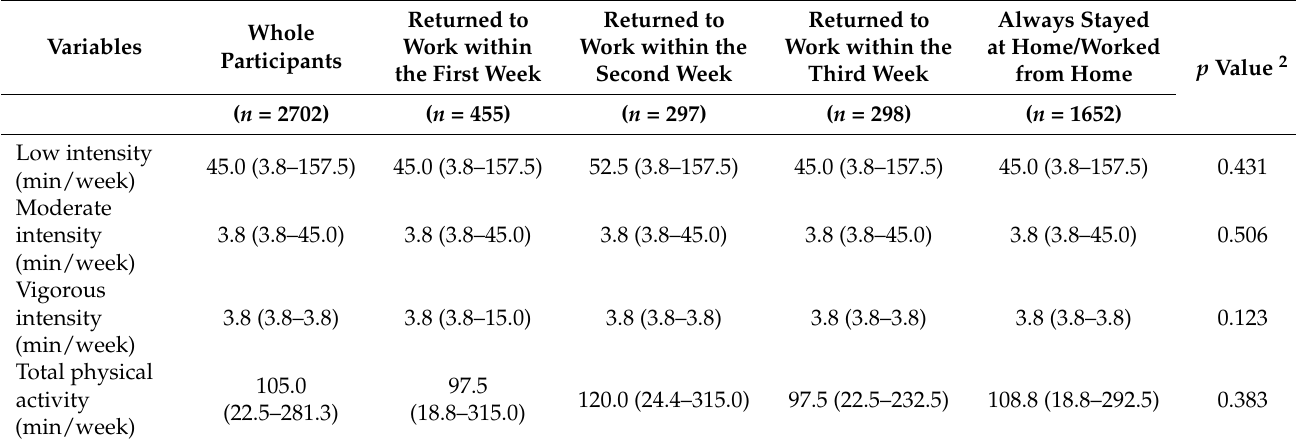
Table 4. Different levels of physical activity during the COVID-19 lockdown by status 1 .